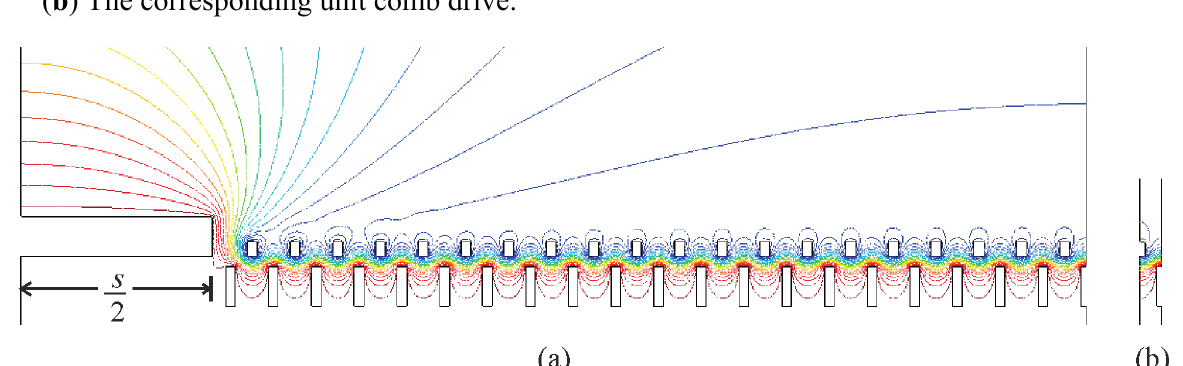
Figure 11. ( a ) One of the models of a row of teeth with a portion of the device layer at the end. The equipotential lines show the electric field being pulled away from the tops of the shorter teeth, lessening the effect of the width of the teeth on the electrostatic force between them; ( b ) The corresponding unit comb